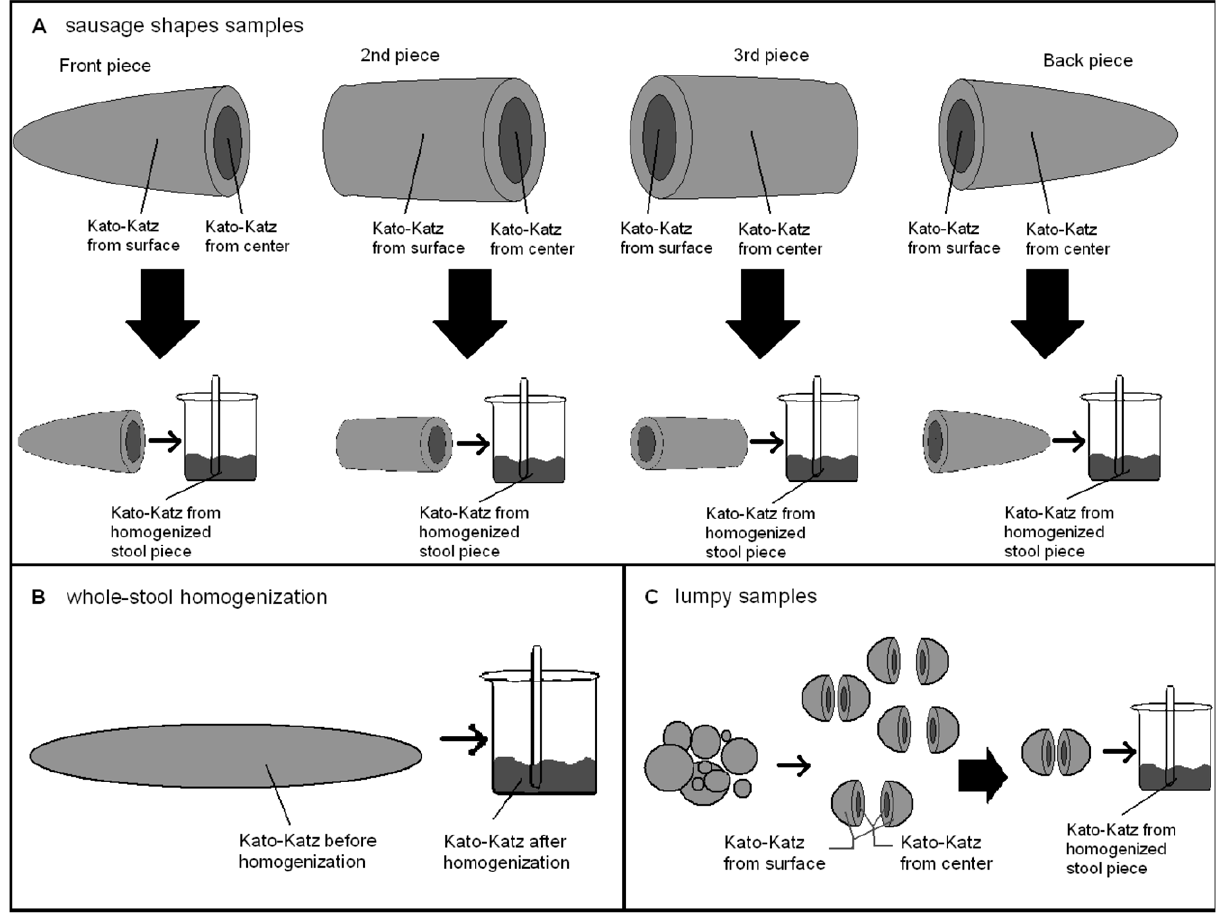
Figure 2. Processing of stool samples according to consistency including whole-stool homogenization. *Sausage-shaped-but-soft samples were processed like in (A) without taking samples from the center.